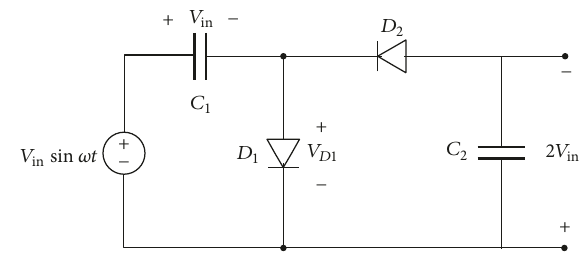
Figure 1: Traditional voltage doubler.